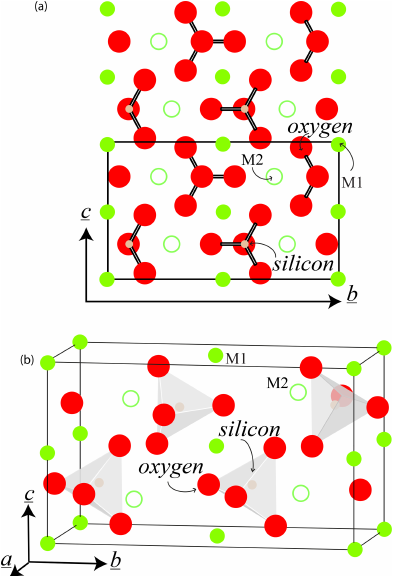
Figure 2. The crystallographic cell of olivine, in the space group Pbnm : (a) in the plane (100) and (b) in three dimensions. The Corey–Pauling–Koltrun color scheme is used for O, Si, and Mg atoms, but the relative radii of the atoms are not preserved to maintain clarity. Empirical atomic radii ( ± 0.12Å) are O = 0.9Å, Si = 1.1Å, and Mg = 1.5Å (see Slater,